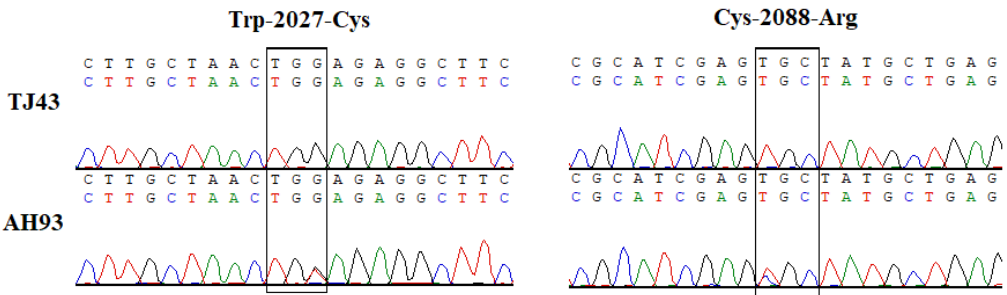
Figure 3. Partial ACCase gene comparison from the resistant (AH93) and susceptible (TJ43) black grass populations.